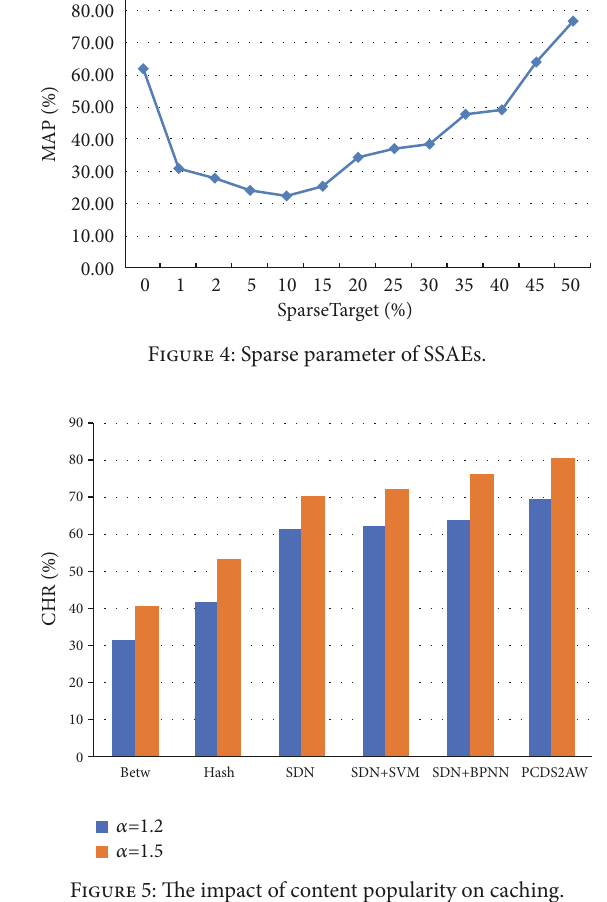
Figure 5: The impact of content popularity on